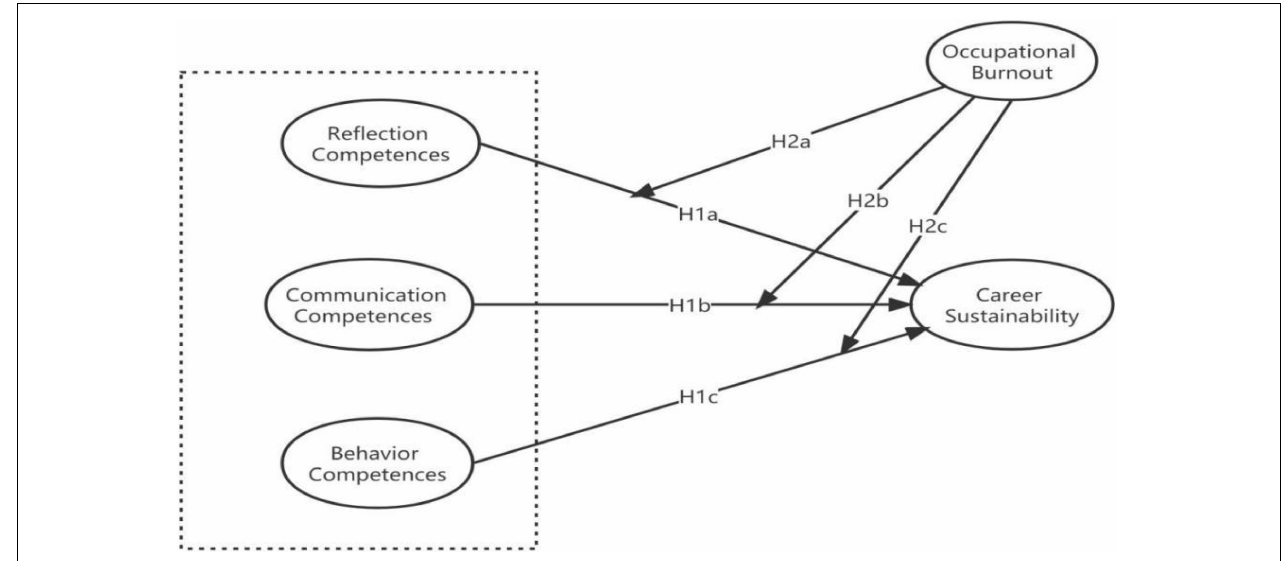
FIGURE 1 | The research framework.